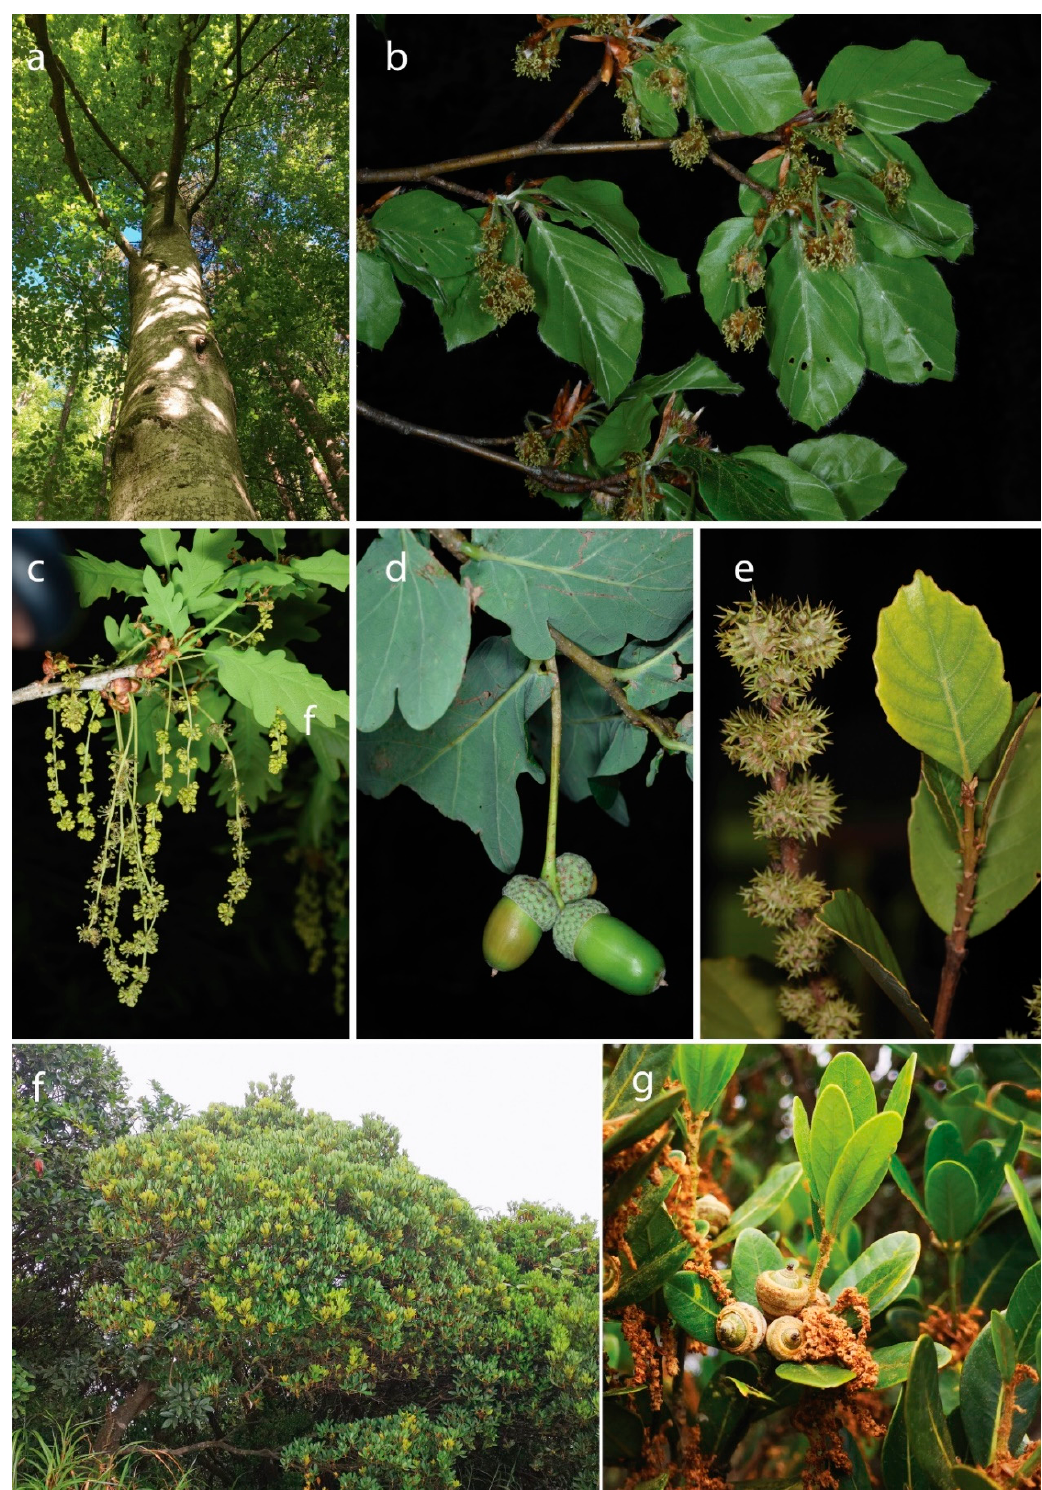
Figure 2. Selected members of the Fagaceae, a large and entirely woody plant family. ( a , b ) Fagus sylvatica , Ueberstorf, Switzerland; ( c , d ) Quercus robur , Enney, Switzerland. Both species belong to the most common trees in European forests; ( e ) Castanopsis delavayi , endemic to Southwest China. Yunnan, China; ( f , g ) Quercus litseoides , Shenzhen, Wutong Mountain, China. The species is one of the rarest and most endangered oaks worldwide. Pictures: E. Kozlowski ( a – e ), Y.-G. Song ( f , g